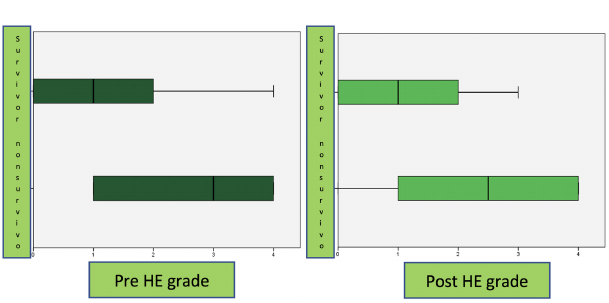
Figure 1. Comparison of HE grade before and after PEX in survivors and non-survivors group. HE, hepatic encephalopathy.